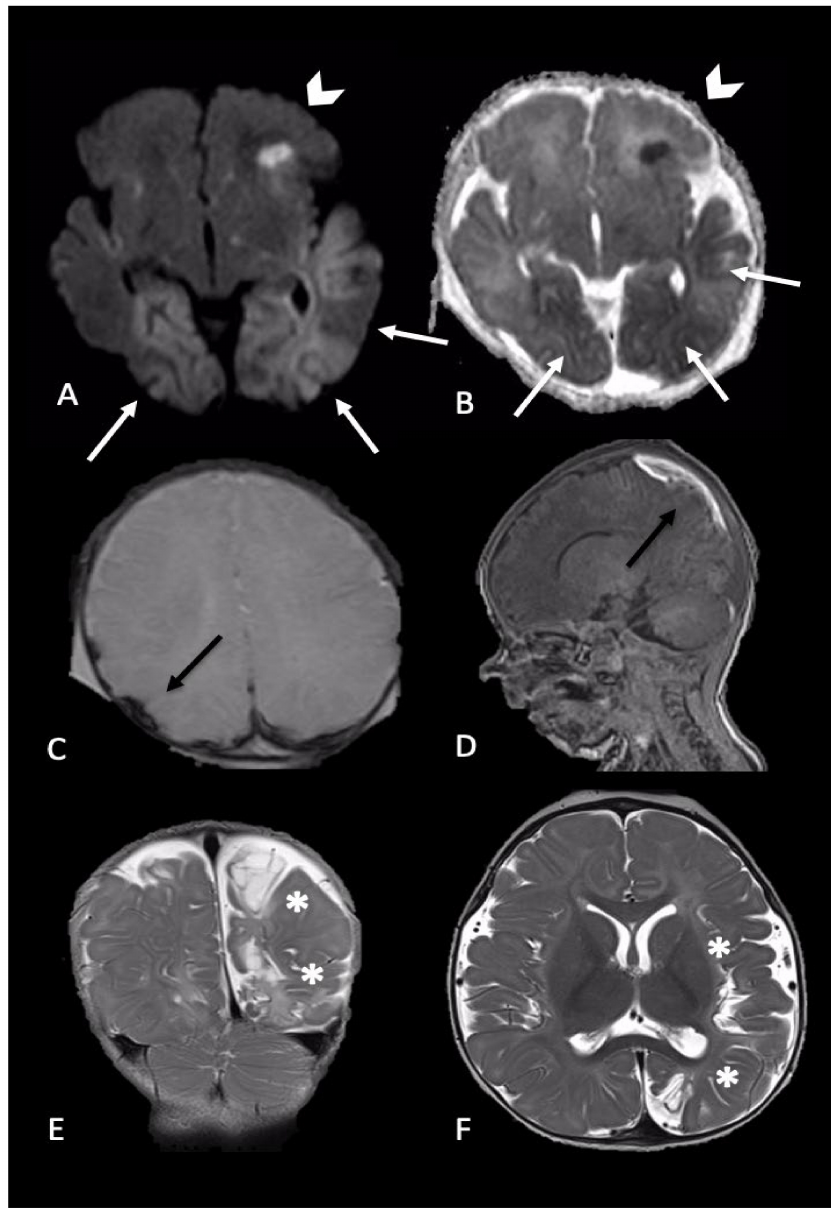
Figure 3. Newborn reached the emergency department for single episode of apnea followed by generalized seizures. MRI performed 4 days later showed intraparenchymal injuries and bilateral extra-axial mixed-intensity fluid collections. In particular, ( A , B ) (axial DWI and ADC maps) showed bilateral temporal and occipital cortical areas of restricted diffusion (white arrows) and a focal area of restricted diffusion localized in the left frontal lobe and diffuse (arrows-head), indicative of acute intraparenchymal injury; ( C , D ) (axial SWI and sagittal T1-W) showed extra-axial blood collection along the parietal convexity bilaterally (black arrows). Six-month follow-up MRI (( E , F ), coronal and axial T2-W) revealed malacic evolution of intraparenchymal damage and consequent expansion of extra-axial spaces due to tissue loss